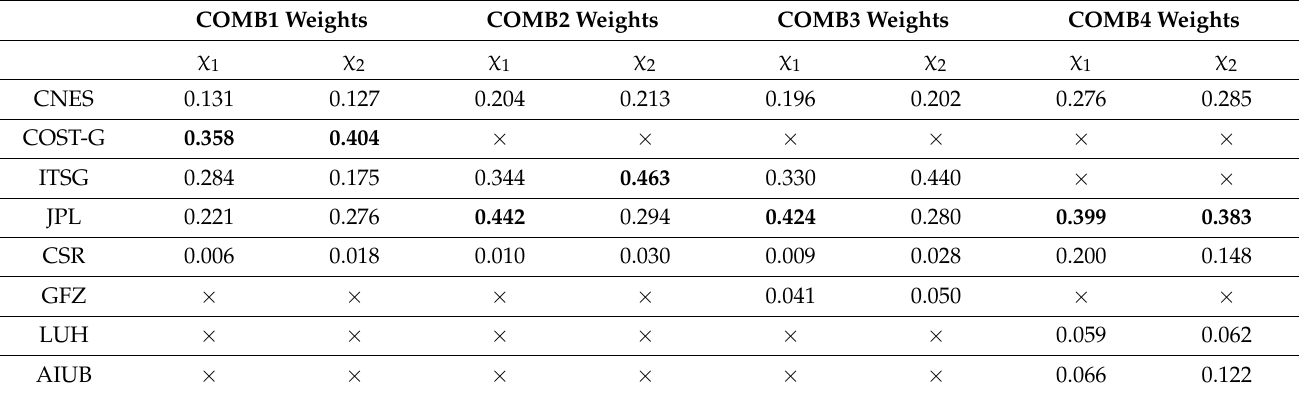
Table 1. Weights for GRACE/GRACE-FO solutions in each COMB solution were determined with the TCH method. The highest weights are